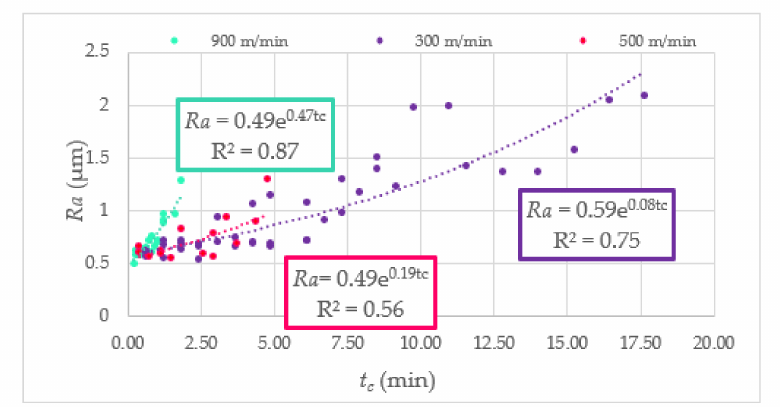
Figure 6. The Ra parameter in function of cutting